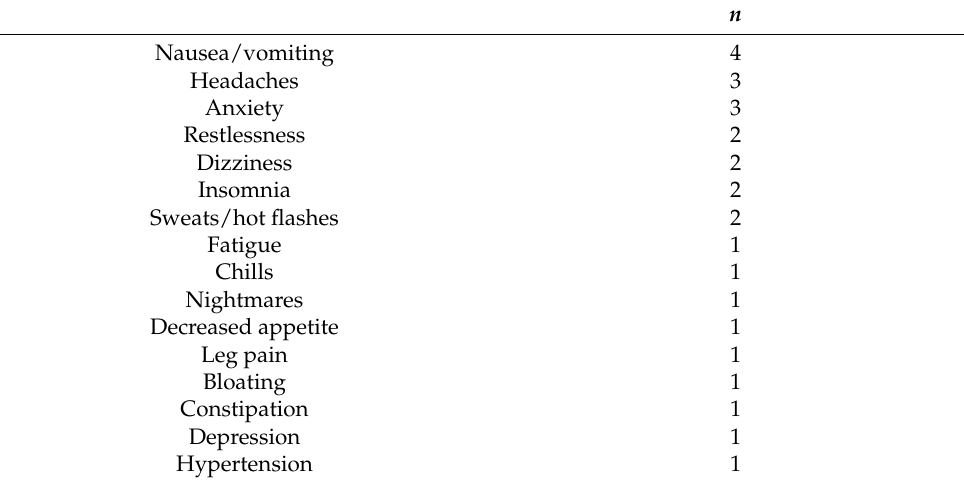
Table 3. Adverse Effects ( n = 11